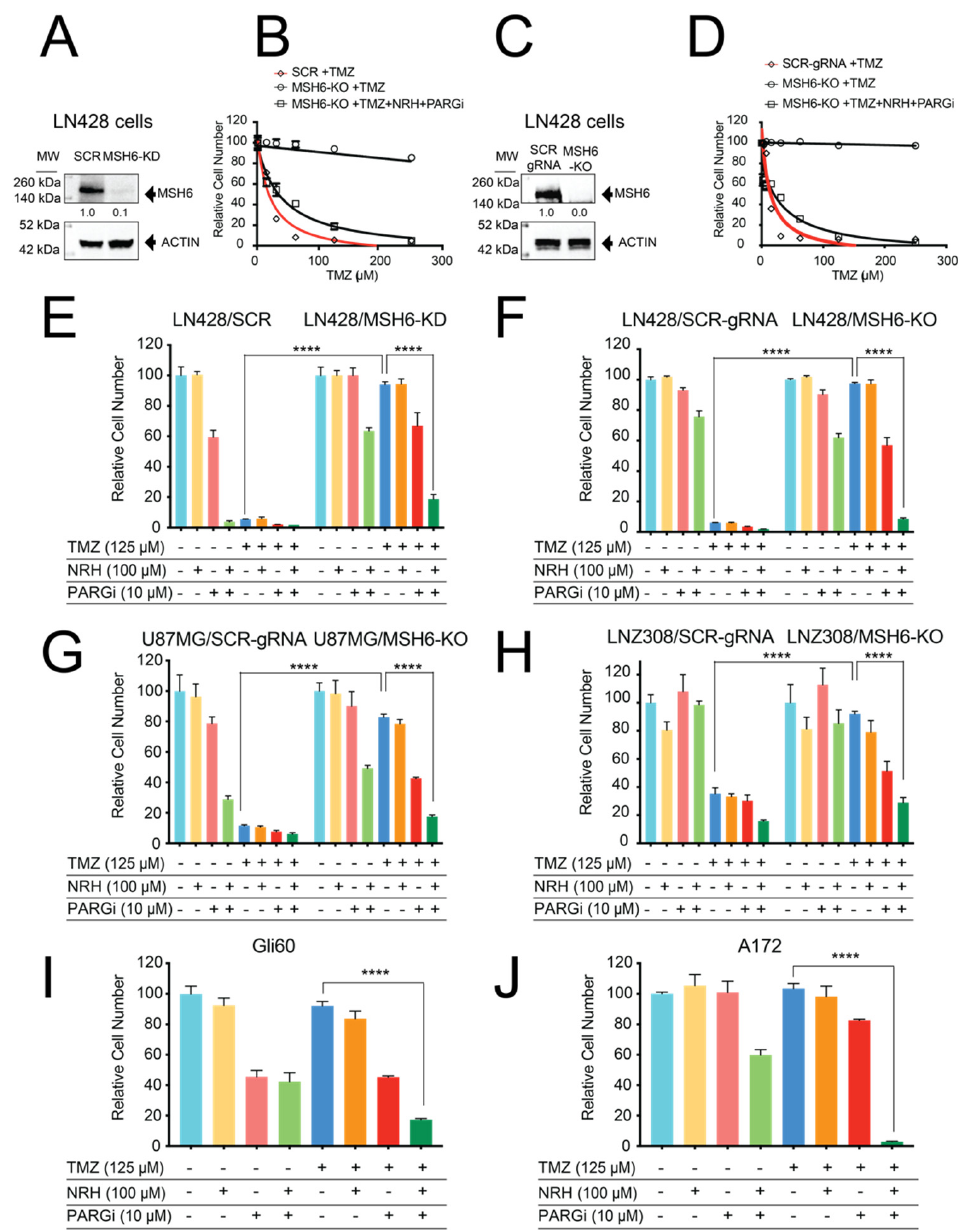
Figure 1. Loss of MSH6 in GBM cells resulted in TMZ resistance that was overcome by co-treatment with TMZ, NRH, and PARGi. ( A ) Immunoblot analysis of the MSH6 levels in LN428 cells trans- duced with lentivirus expressing shRNA-targeting MSH6 (KD) or a non-targeting scrambled shRNA (SCR). β -Actin was used as the loading control. ( B ) LN428/SCR or LN428/MSH6-KD cells after treatment with TMZ alone or TMZ supplemented with NRH (100 μ M) + PARGi (10 μ M) for 7 days (TMZ doses as indicated), normalized to DMSO. ( C ) Immunoblot analysis of the MSH6 levels in LN428 cells after MSH6 gene mutation (knockout, KO) by CRISPR/Cas9 with a pool of three gRNAs compared to a non-targeting scrambled gRNA (SCR-gRNA). β -Actin was used as the load- ing control. ( D ) LN428/SCR-gRNA or LN428/MSH6-KO cells after treatment with TMZ alone or TMZ supplemented with NRH (100 μ M) + PARGi (10 μ M) plus TMZ for 7 days (TMZ doses as indicated), normalized to DMSO. ( E ) LN428/SCR or LN428/MSH6-KD cells treated with DMSO, NRH (10 μ M), PARGi (10 μ M), N + P, TMZ (125 μ M), T + N, T + P, or T + N + P for 7 days, normalized to DMSO: (**** p < 0.0001, two-way ANOVA). ( F ) LN428/SCR-gRNA or LN428/MSH6-KO cells treated with DMSO, NRH (100 μ M), PARGi (10 μ M), N + P, TMZ (125 μ M), T + N, T + P, or T + N + P for 7 days, normalized to DMSO: (**** p < 0.0001, two-way ANOVA). ( G ) U87MG/SCR-gRNA or U87MG/MSH6-KO cells treated with DMSO, NRH (100 μ M), PARGi (10 μ M), N + P, TMZ (125 μ M), T + N, T + P, or T + N + P for 7 days, normalized to DMSO: (**** p < 0.0001, two-way ANOVA). ( H ) LNZ308/SCR-gRNA or LNZ308/MSH6-KO cells treated with DMSO, NRH (100 μ M), PARGi (10 μ M), N + P, TMZ (125 μ M), T + N, T + P, or T + N + P for 7 days, normalized to DMSO: (**** p <